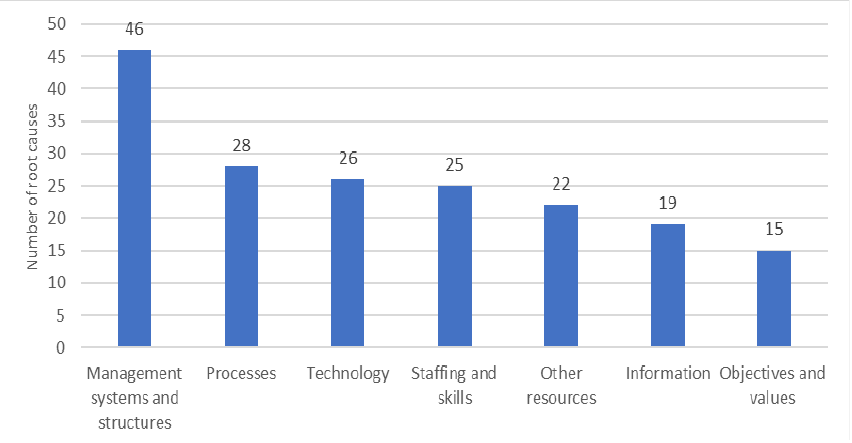
Figure 20: Number of root causes per ITPOSMO design–reality gap dimension